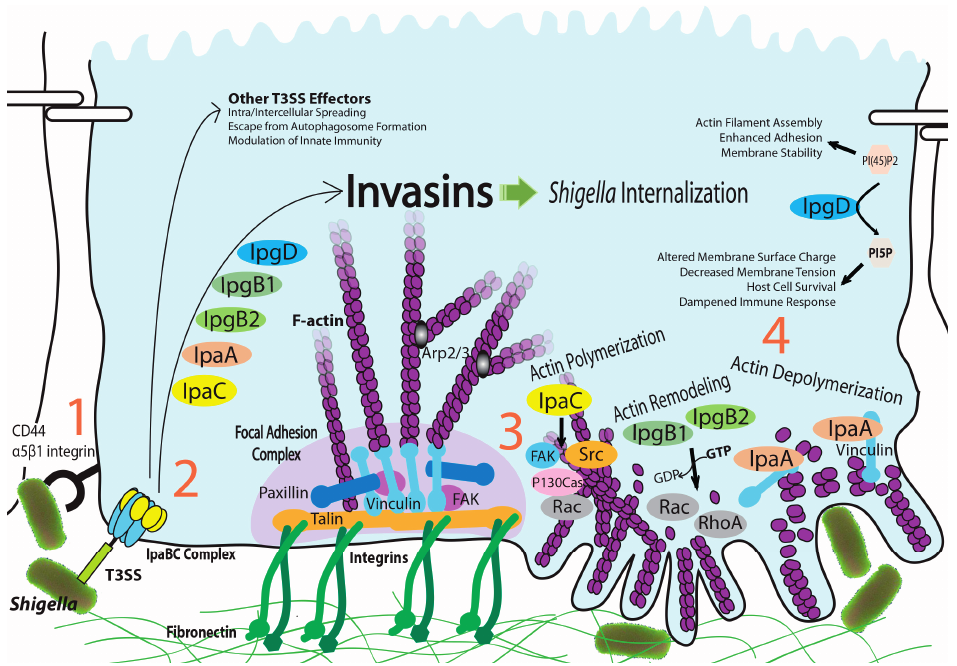
Figure 1. Overview of Shigella internalization with the action of T3SS invasins injected into the host cell cytosol. Targeting of key regulators in actin dynamics by invasins is highlighted in this schematic. Internalization of Shigella is accomplished by (1) attachment to host cells by an interaction between the IpaB/C complex and CD44/ α 5 β 1 integrins; (2) injection of T3SS invasins; (3) disassembly of focal adhesion complexes, microspike formation and actin remodeling and (4) actin depolymerization and ruffle formation. The sequence of events occurs at the intimate bacterial contact